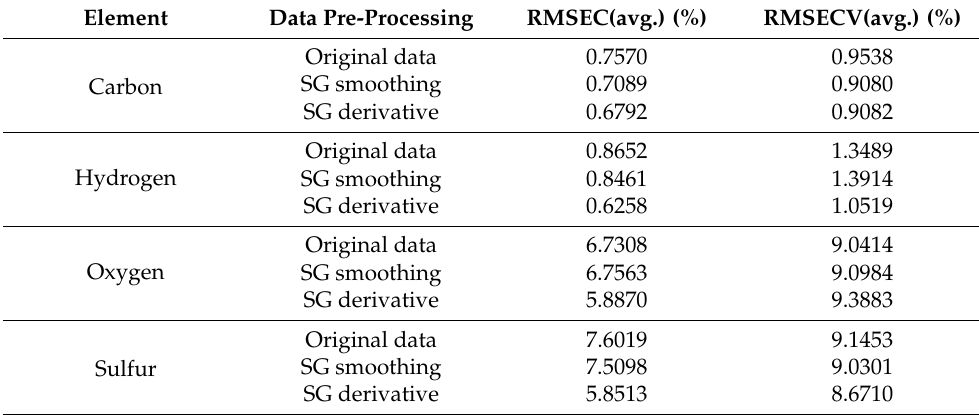
Table 1. Comparison of RMSE average (%) of mixed coal elements between original data and pre-processed data.